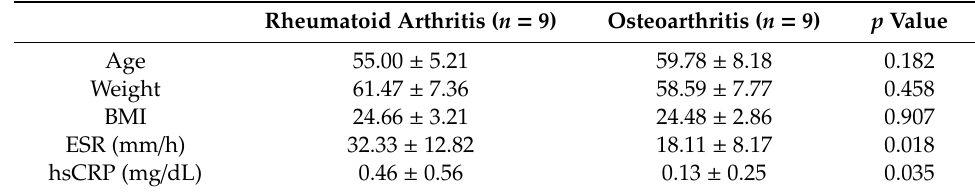
Table 1. Characteristics of study